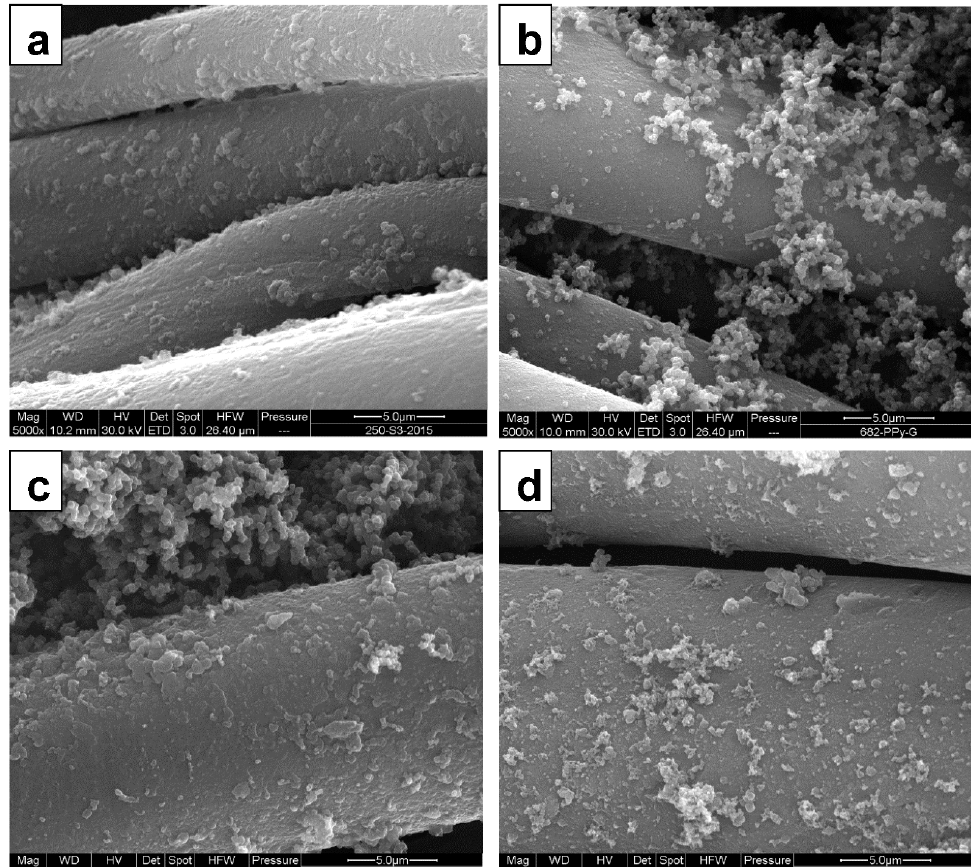
Figure 4. Scanning electron micrographs of cotton fibers coated with: ( a ) PANI; ( b ) PPy; ( c ) PANI+PPy; and ( d ) PPy+PANI.